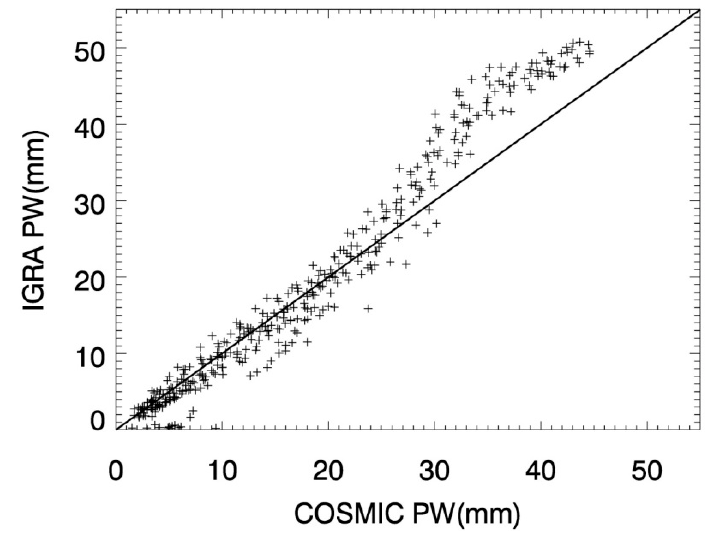
Figure 3. Scatterplot of latitudinal monthly mean COSMIC and IGRA PW.